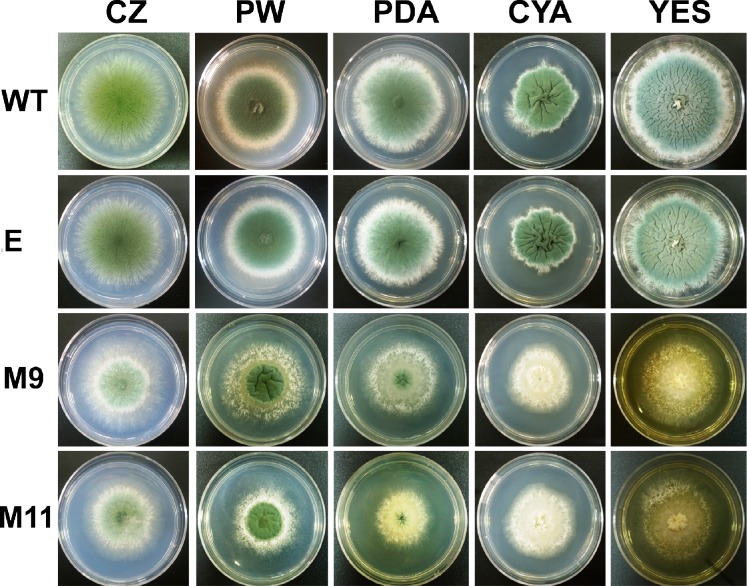
Phenotypes of different strains of P. roqueforti.The colonies were grown for 7 days at 28° C in Czapek (CZ), Power (PW), PDA, CYA, and YES media. WT: P. roqueforti CECT 2905; M9 and M11: pcz1 silenced transformants; E: P. roqueforti CECT 2905 containing empty pJL43-RNAi vector. Note that the latter strain was undistinguishable from the wild-type strain.